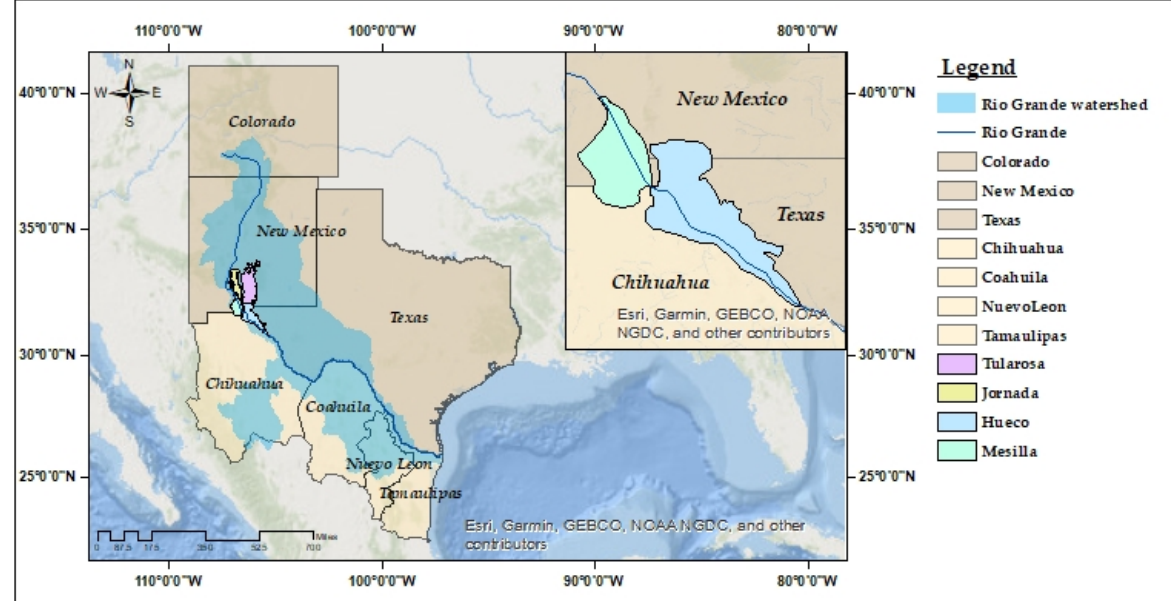
Figure 1. Map of Rio Grande watershed and river mainstem through the seven states in the US and Mexico.